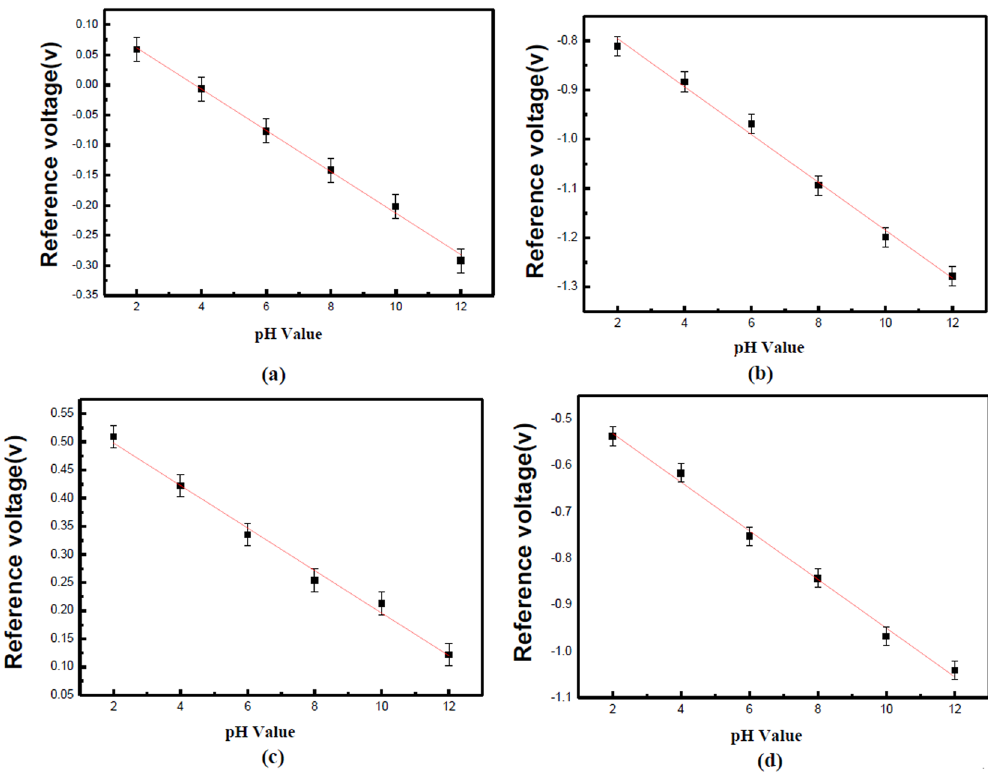
Figure 7. The linearity and sensitivity extracted from normalized C-V curve for the CeO 2 sample ( a ) without NH 3 plasma treatment and ( b ) with NH 3 plasma treatment for 3 min. The normalized C-V curve of the Ce 2 Ti 2 O 7 sample ( c ) without NH 3 plasma treatment and ( d ) with NH 3 plasma treatment for 3